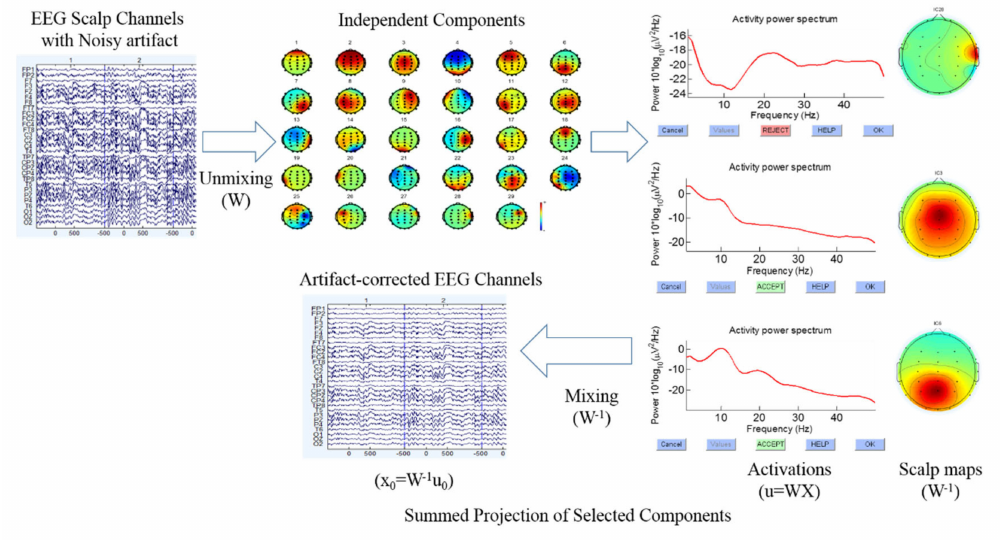
Figure 3. Flowchart of the independent component analysis and back projecting the retained independent components to artifact free EEG channels (i.e., clean EEG